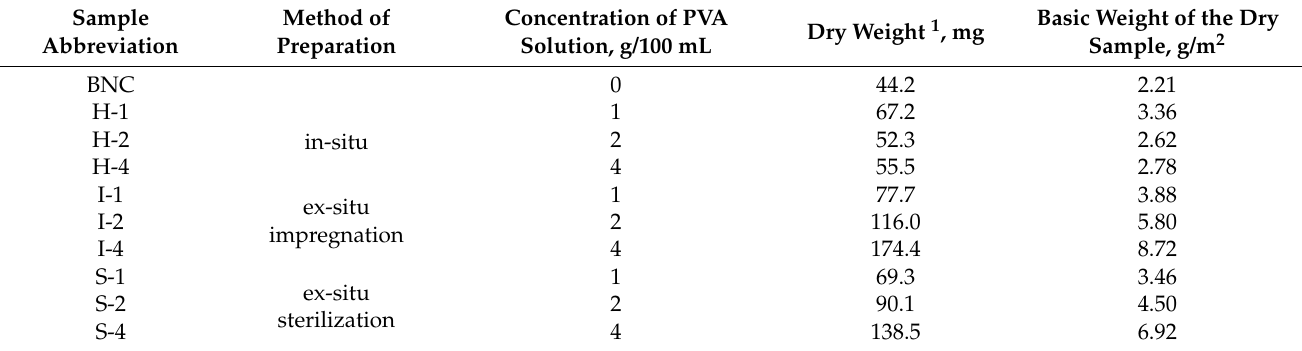
Table 2. The base weight of dry BNC and BNC/PVA composites obtained by various